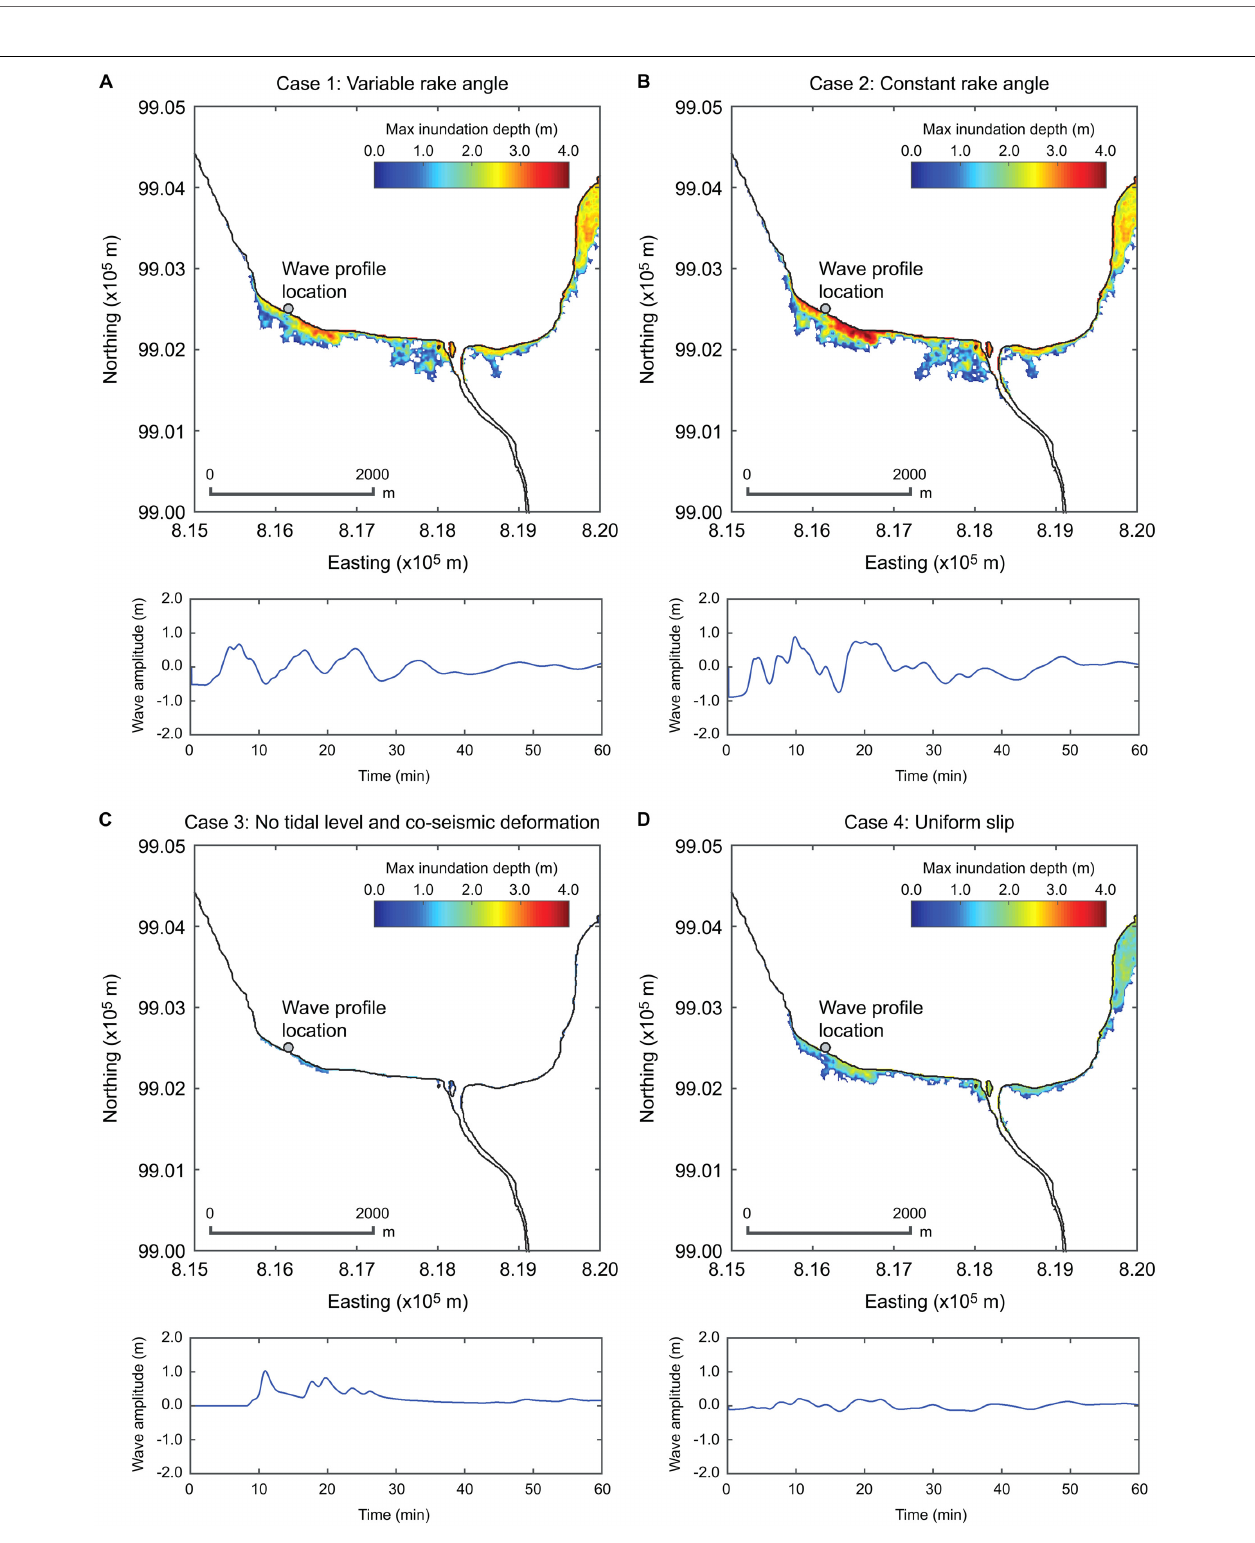
FIGURE 13 | Tsunami inundation simulation results in the Palu area (see Figure 10C ): (A) the USGS model with the variable rake angle (Case 1), (B) the USGS model with the constant rake angle (Case 2), (C) the USGS model with the uniform slip distribution with the constant rake angle (Case 3), and (D) the USGS model with the variable rake angle without considering the effects of tidal level and co-seismic ground deformation (Case 4). For Cases (A–C) , the maximum inundation depth is computed by taking into account co-seismic ground deformation and tidal level, while the wave profile at the near-shore location (indicated by a gray circle on a map) is with respect to the reference level of the tsunami